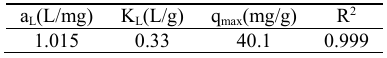
Table 1. Parameters of Langmuir isotherm equations, regression coefficients (r) for the adsorption of MB on FNMMO NPs at 25 °C and pH